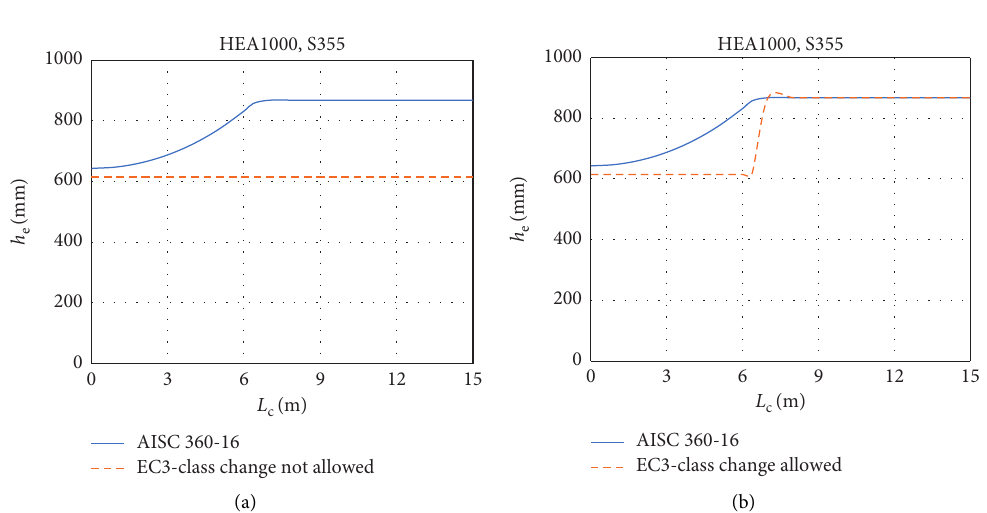
Figure 1: For a steel grade of S355, the variation of effective height (h e ) of HEA1000 section with the effective length (L c ) of the member. The effective heights computed using AISC 360-16 are compared with those computed using EC3 without making the class change allowed in Clause 5.5.2(9) in (a) and with making the class change in